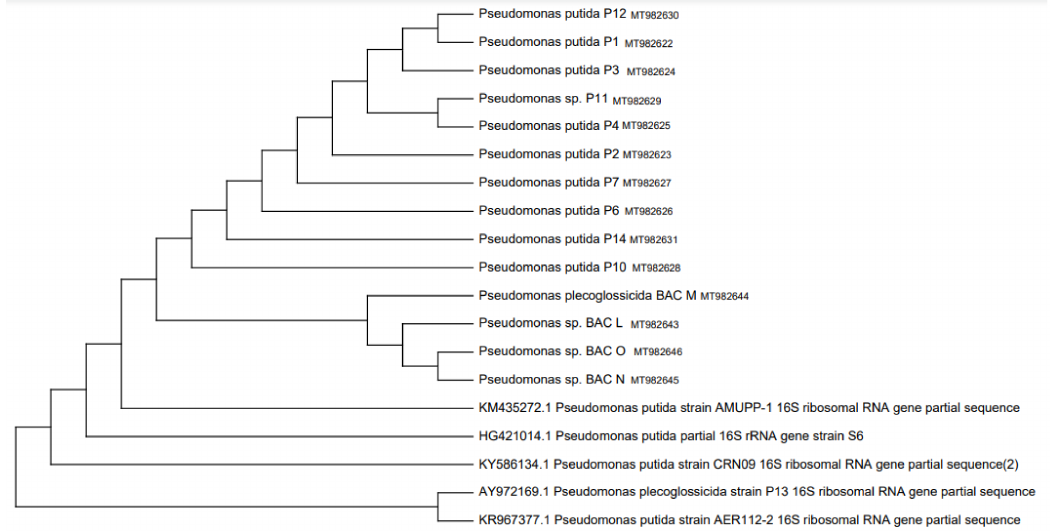
Figure 2. Phylogenetic tree built according to the maximum likelihood method based on the rela- tionship between the 16S rRNA gene sequences of the Pseudomonas strains isolated from the Persea americana rhizosphere and related Pseudomonas species. Sequences of the 16S rRNA gene of the Pseudomonas putida strain was arbitrarily chosen as a sequence outside the